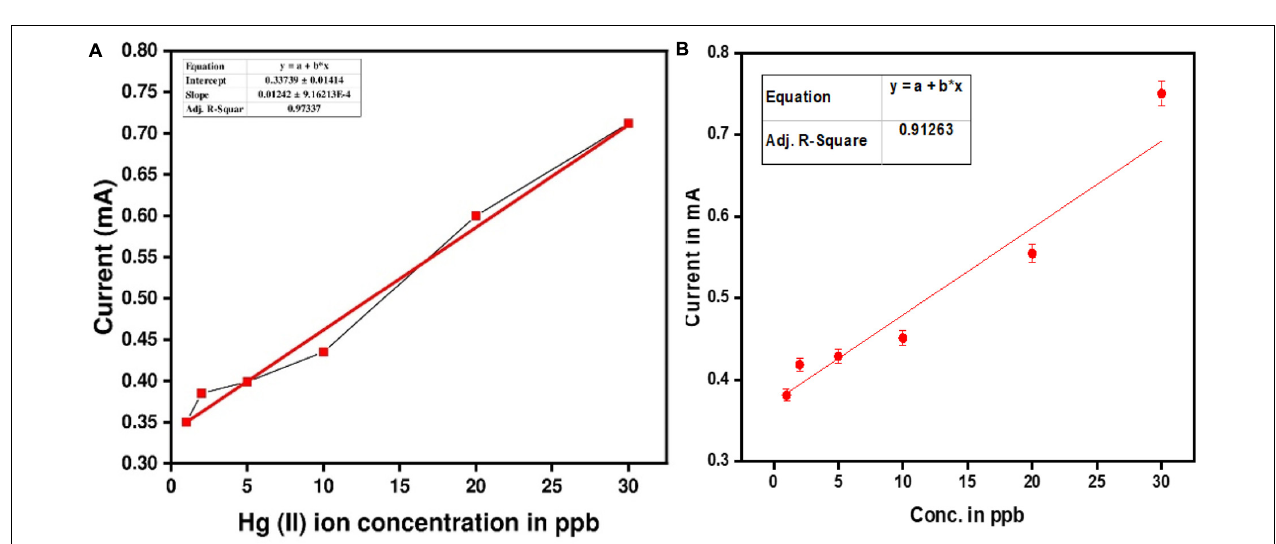
FIGURE 10 | (A) Linear relationship between Hg(II) ion concentration (in ppb) and measured current (mA). (B) Calibration plot of EDTA modified PANI/GO composite.